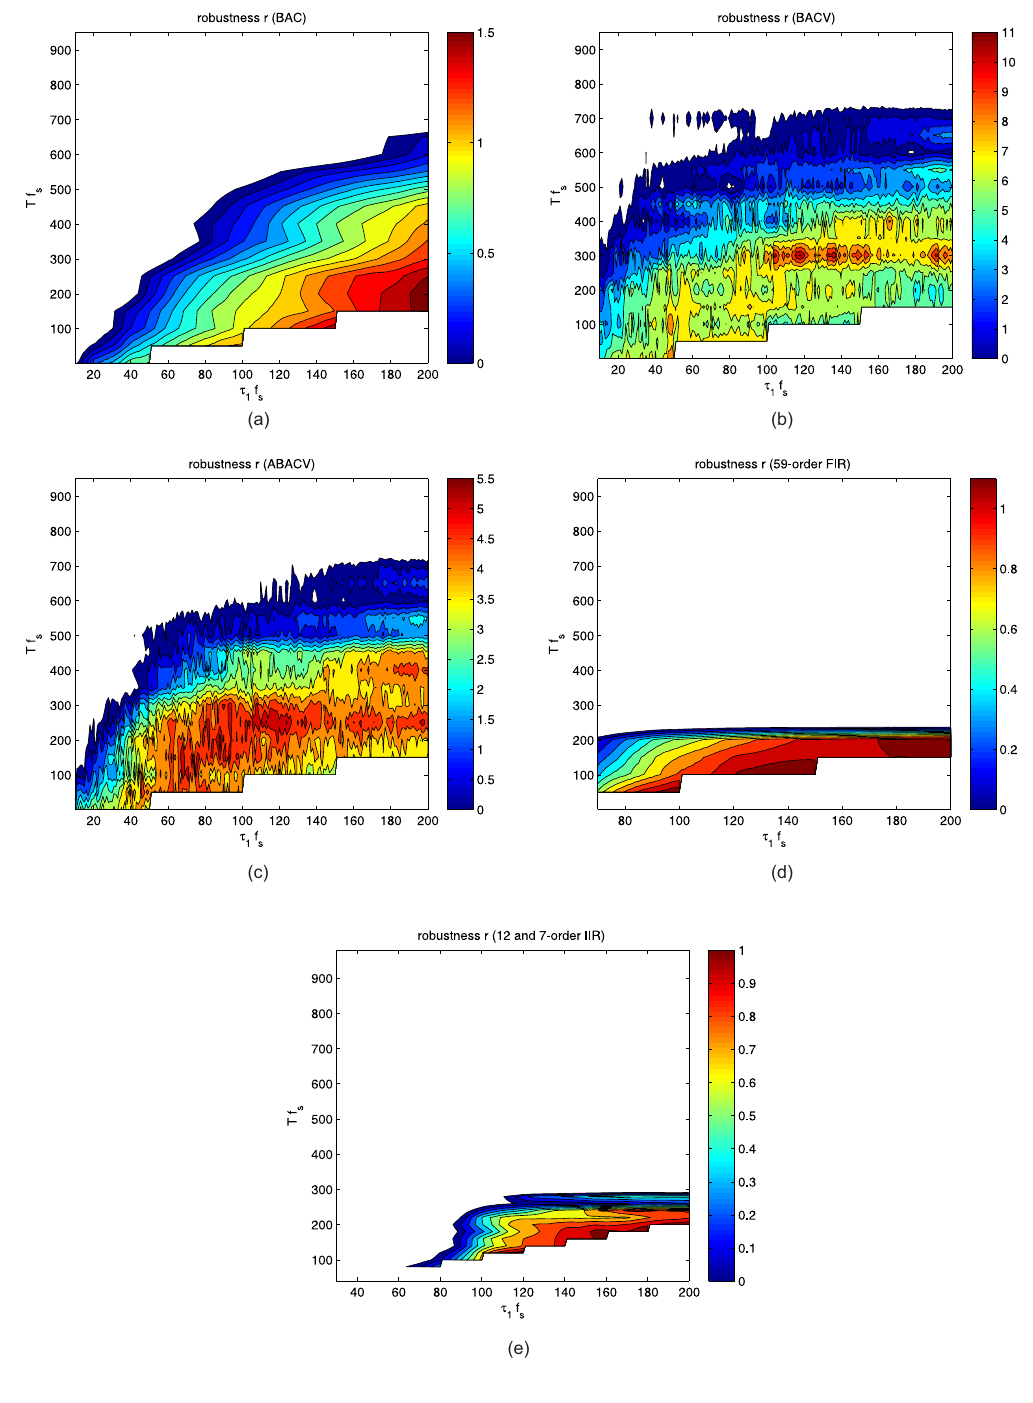
Figure 7. Robustness test of ( a ) BAC, ( b ) BACV, ( c ) ABACV algorithms, ( d ) a bandpass FIR-based algorithm ( e ) and an IIR-based